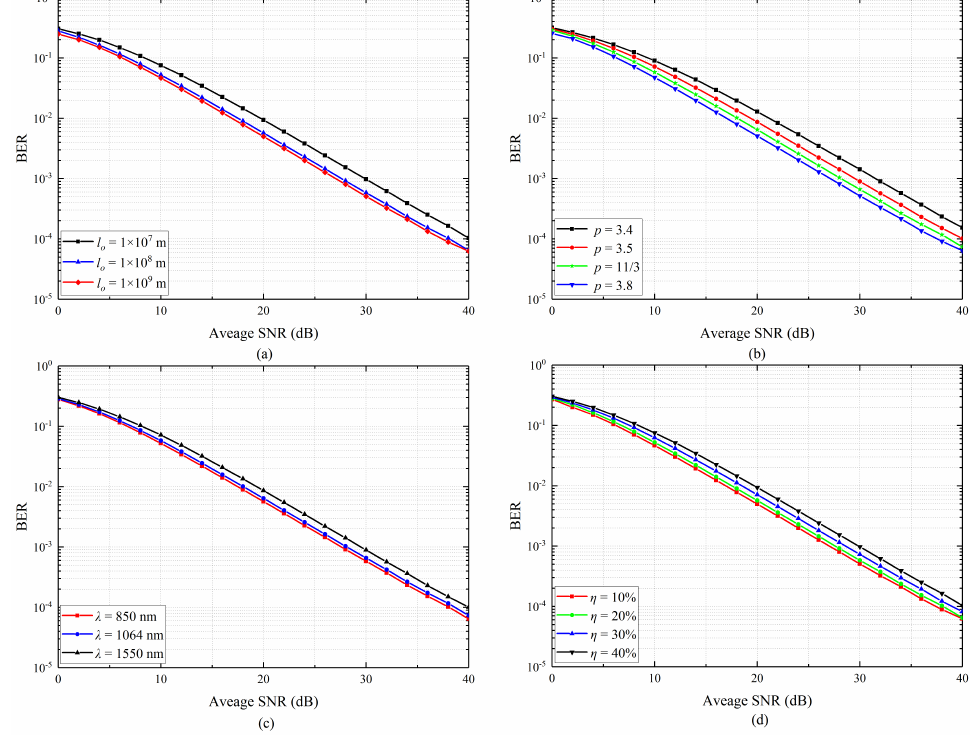
Figure 9. Under coronal turbulence, the average BER performance of the hybrid RF/FSO system against ( a ) outer scale, ( b ) spectral index, ( c ) wavelength, ( d ) density fluctuation factors. Figure 10 describes the relationship between the average channel capacity and SNR.